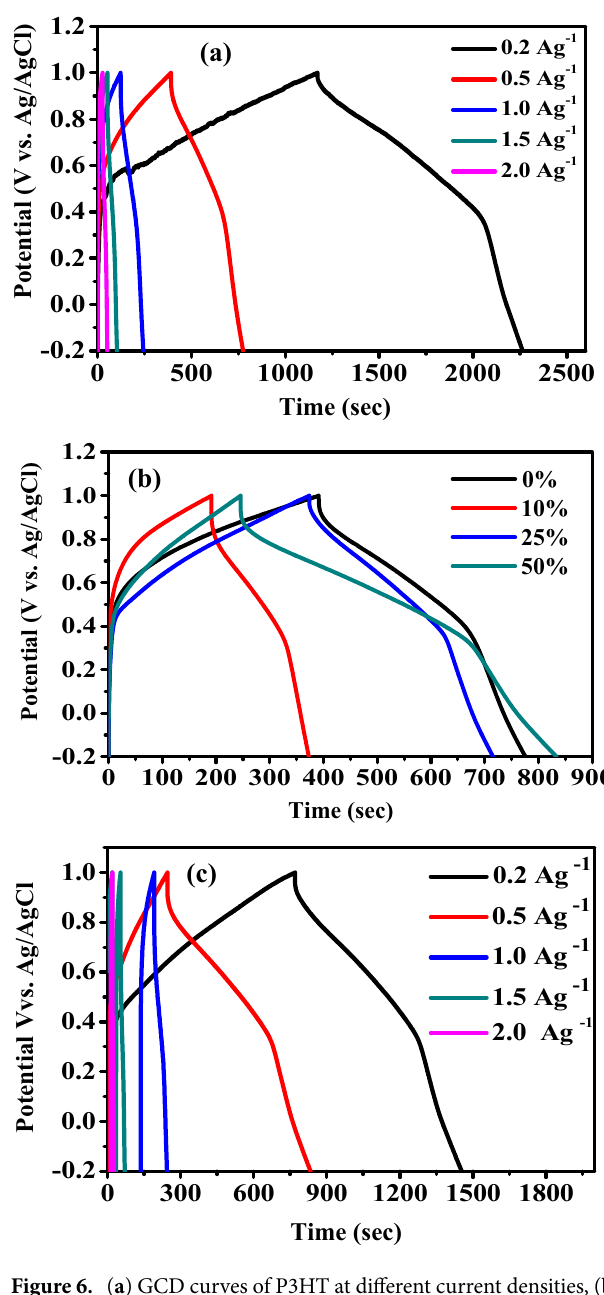
Figure 6. ( a ) GCD curves of P3HT at different current densities, ( b ) GCD curves of P3HT/SWCNTs electrodes with different SWCNTs ratios at 0.5 Ag −1 and ( c ) GCD curves of P3HT/50% SWCNTs at different current